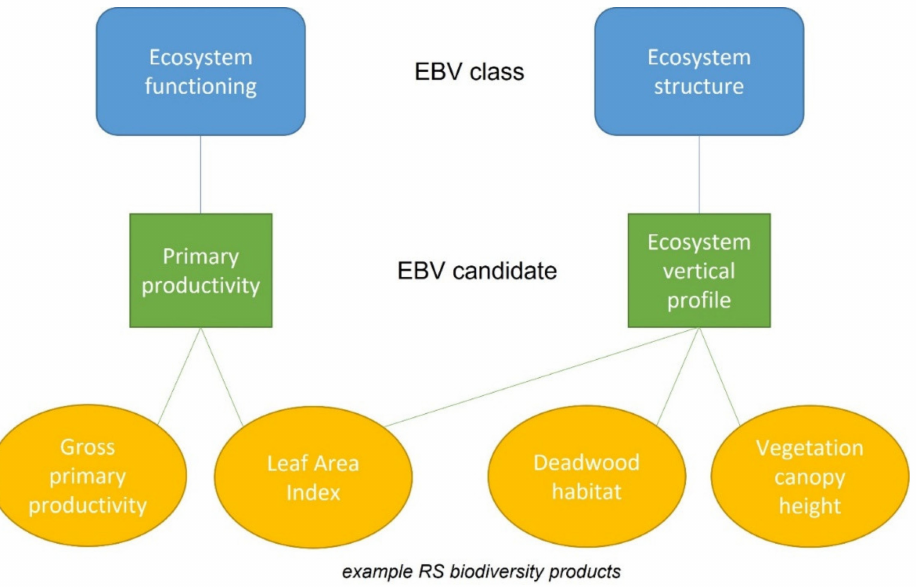
Figure 2. Two examples of EBV classes and candidates within the multi-tiered Essential Biodiversity Variable framework. The example remote sensing biodiversity products are variables that describe part of the EBV candidate and class (according to Skidmore et al.